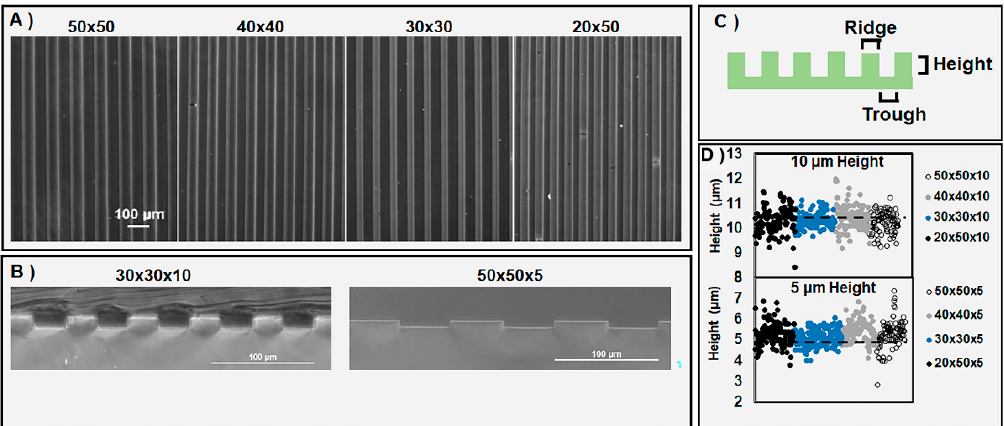
Figure 1. Micropatterned polydimethylsiloxane (PDMS) fabricated via soft lithography. ( A ) Top-down, microscopic view of ridge-by-trough geometry of substrates. Scale bar = 100 µ m. ( B ) Cross-sectional representative images show the 3D characteristics of a 30 × 30 pattern with 10 µ m height (30 × 30 × 10) and 50 × 50 pattern with 5 µ m height (50 × 50 × 5), respectively. ( C ) Three-dimensional PDMS surfaces consisted of three unique dimensions: ridge, trough, and height. ( D ) Pattern heights for four unique dimensions, where dashed lines represent the average heights of all the patterns; n = 5 unique substrates per dimension, with 20 height measurements per substrate.